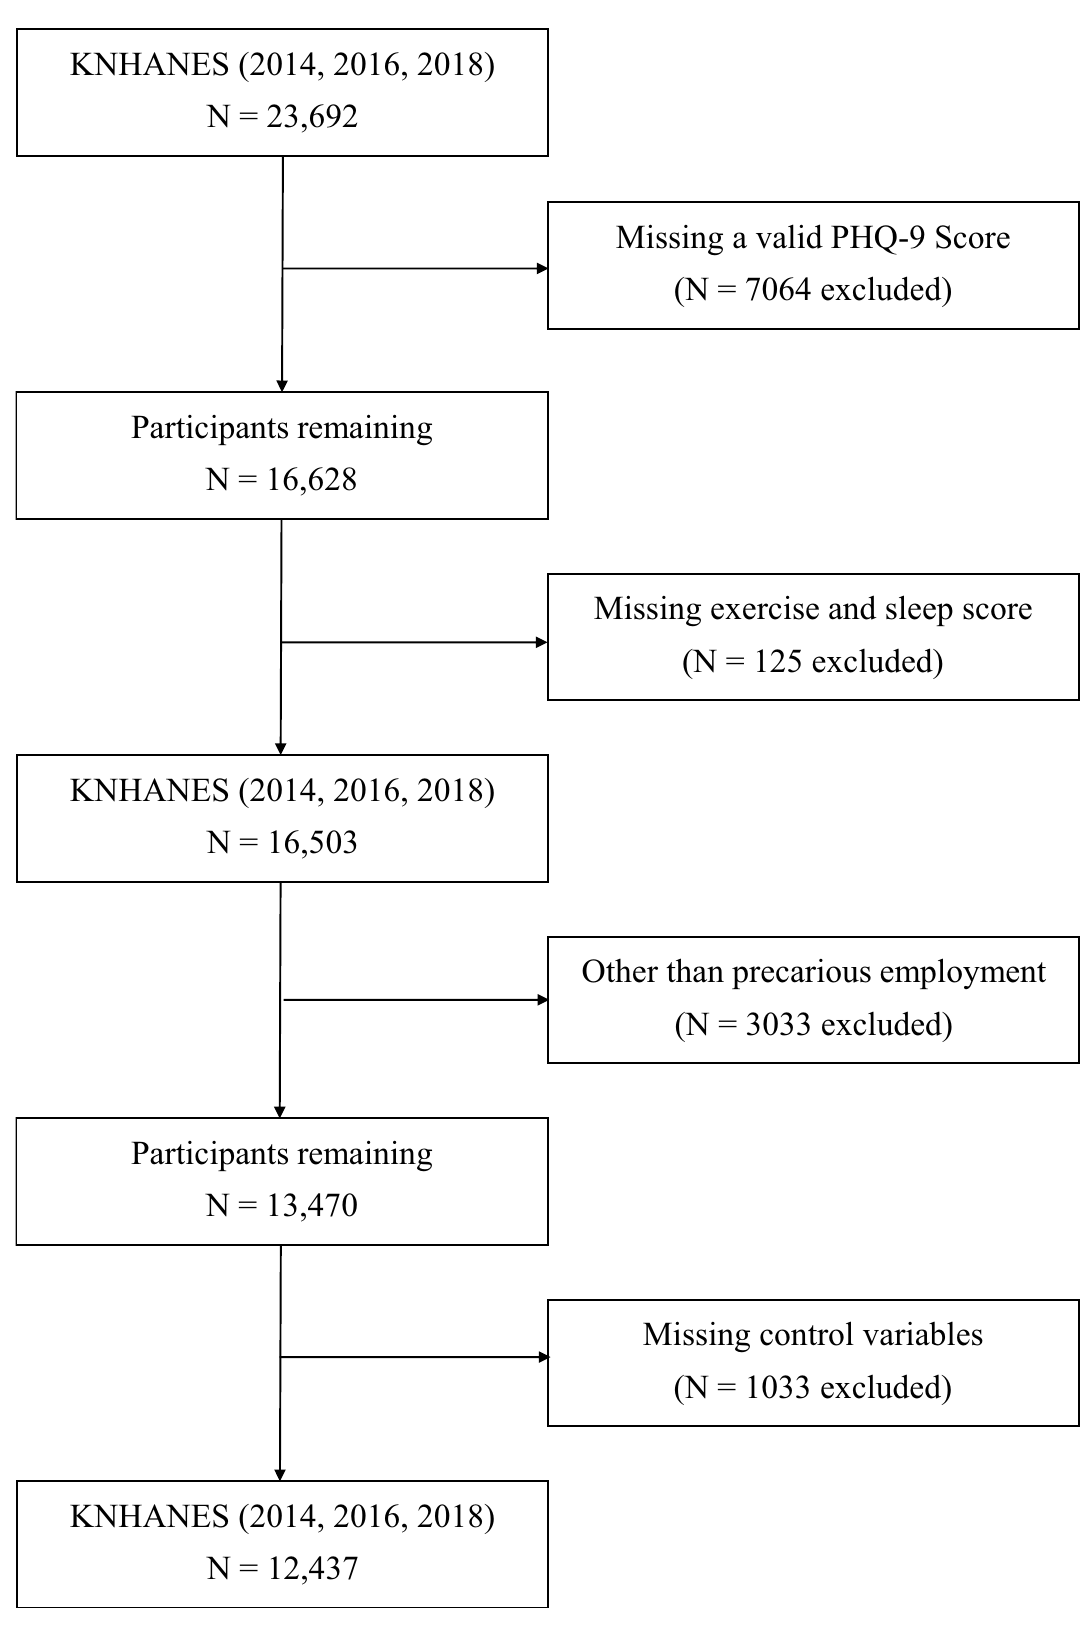
Figure 1. Flow diagram of the study